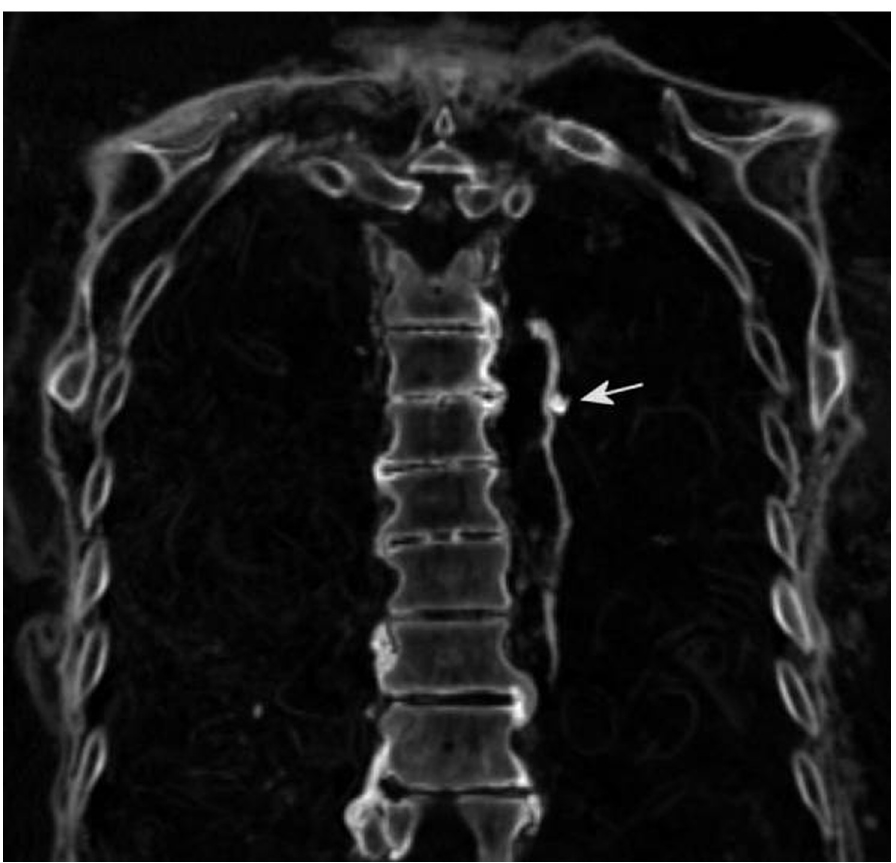
Fig 5. Sample of the CT scans of the lungs: Here the retracted left lung shows hilar calcifications (arrow) and significant osteophytosis of the vertebrae.